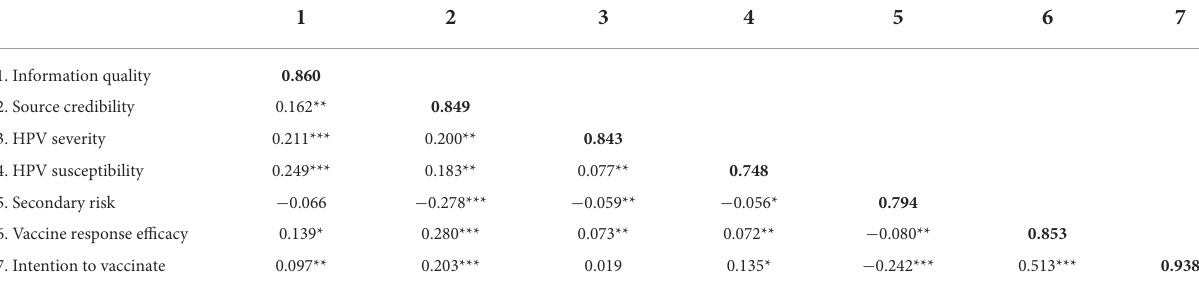
TABLE 3 Pearson correlation analysis and discriminant